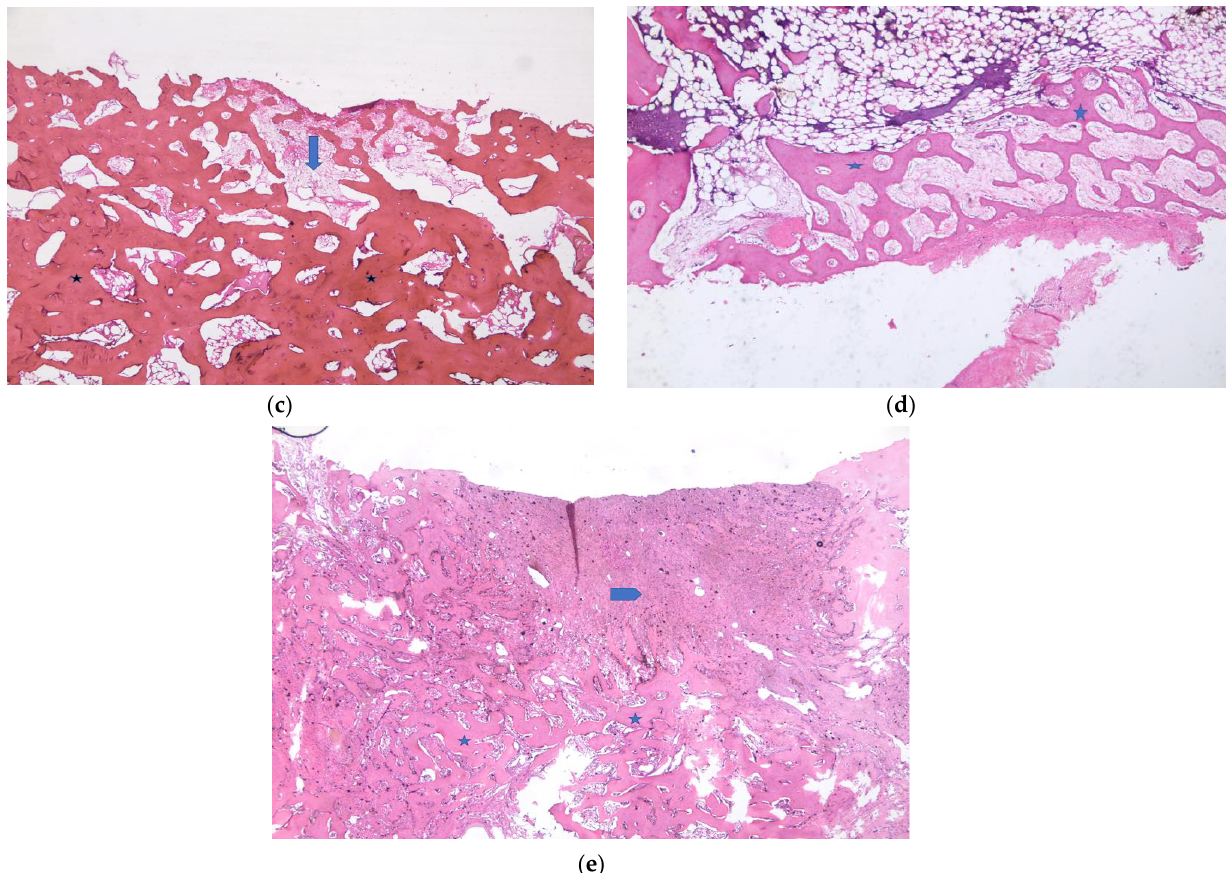
Figure 6. Week 6. ( a ). Empty defect group. Fibrosis and a small amount of vein proliferation among new bone formations in the defect area are observed. *: new bone formation areas; arrows: fibrosis (H&E ×40). ( b ). HY defect group . Highly mature new bone formation is observed from one end of the defect area. Fatty bone marrow is present in between. *: new bone formation areas (H&E ×200). ( c ). G+HY defect group. Sporadic fibrosis among highly dense, mature-looking bone tissues. *: new bone formation areas; arrows: fibrosis (H&E ×40). ( d ). CM defect group. New bone trabeculas connecting with each other and accompanied by loose collagen tissue that is almost filling the defect area are observed. *: new bone formation areas (H&E ×40). ( e ). G+CM defect group. Clusters of fibrosis among the dense new bone formation areas in the defect are observed. *: new bone formation areas; arrows: fibrosis (H&E ×40).